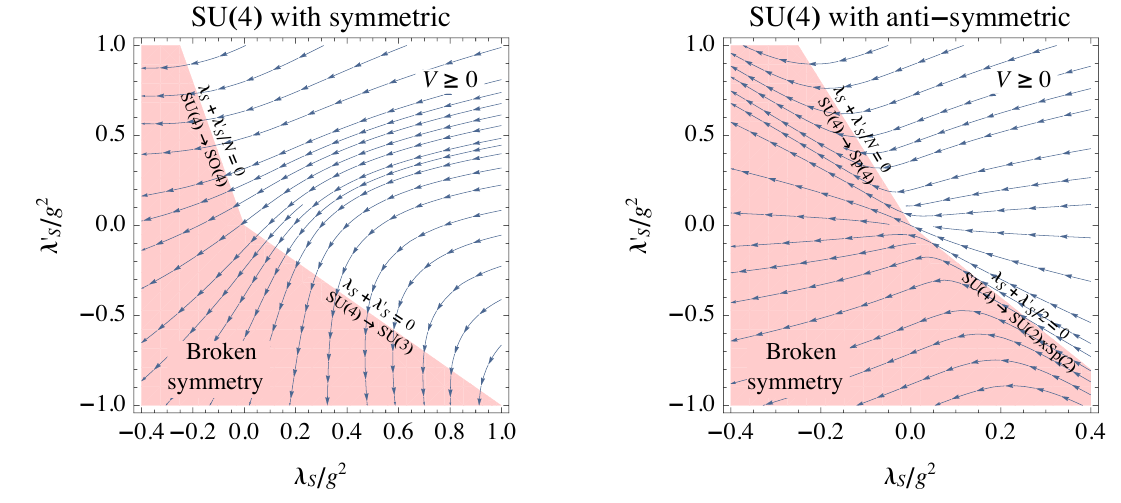
Figure 2 . Coleman-Weinberg symmetry-breaking patterns for a SU( N ) gauge theory with a scalar in the symmetric (left) and anti-symmetric (right): the RGE (cid:13)ow towards low energy of its quartics (cid:21) S and (cid:21) 0 can intersect the instability conditions in both their branches, leading to the two di(cid:11)erent S breaking patterns discussed in the